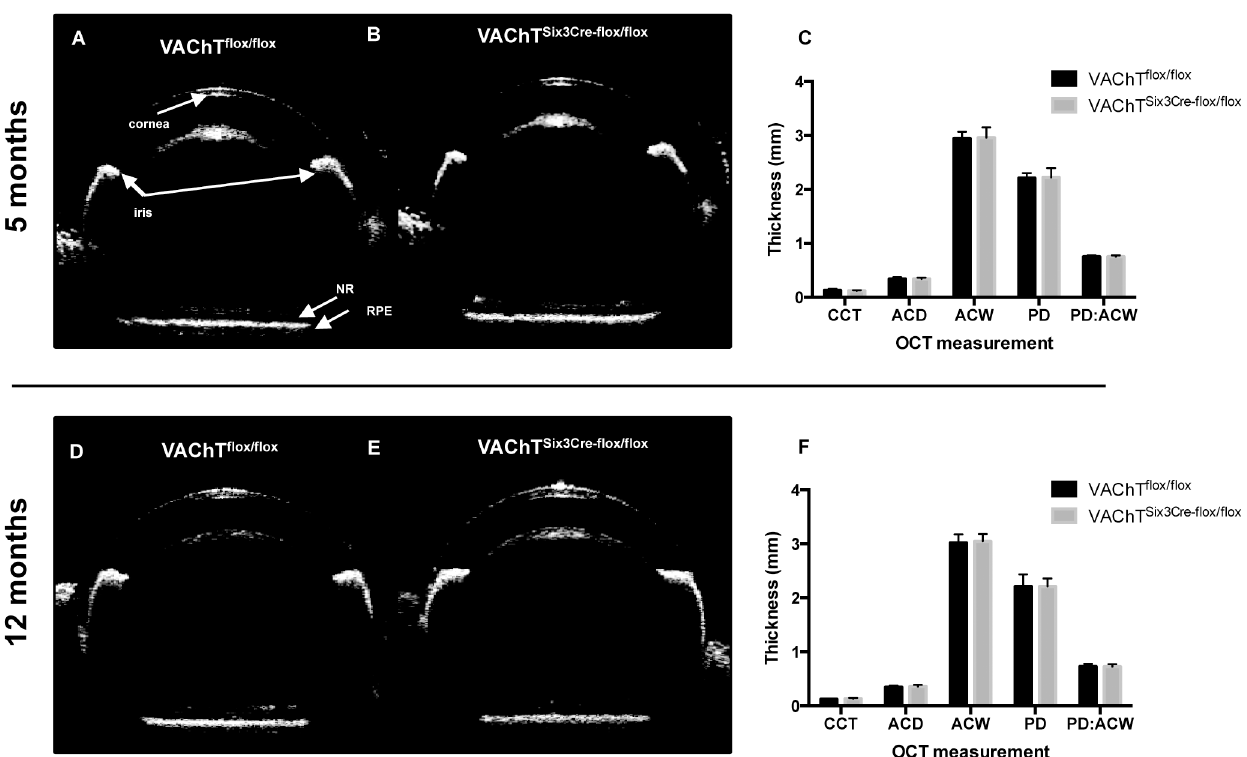
Fig 11. Characterization of anterior segment morphology. OCT images of the anterior segment and retina assessed for morphological changes and the amount of light reaching the retina (A, B, D & E). None of the anterior components of the eye are different between mutant mice and littermate controls at 5 (VAChT Six3-Cre-flox/flox , n = 6; control VAChT flox/flox , n = 12), or at 12 months of age (VAChT Six3-Cre-flox/flox , n = 5; control, n = 5). Images of the anterior segment have been combined with images of the retina. NR, neural retina; RPE, retinal pigment epithelium. (C, F) Central cornea thickness (CCT), anterior chamber diameter (ACD), anterior chamber width (ACW), pupil diameter (PD) and ratio of pupil diameter: anterior chamber depth (PD:ACW) did not differ between VAChT Six3-Cre-flox/flox and VAChT flox/flox mice at 5 or 12 months, respectively.